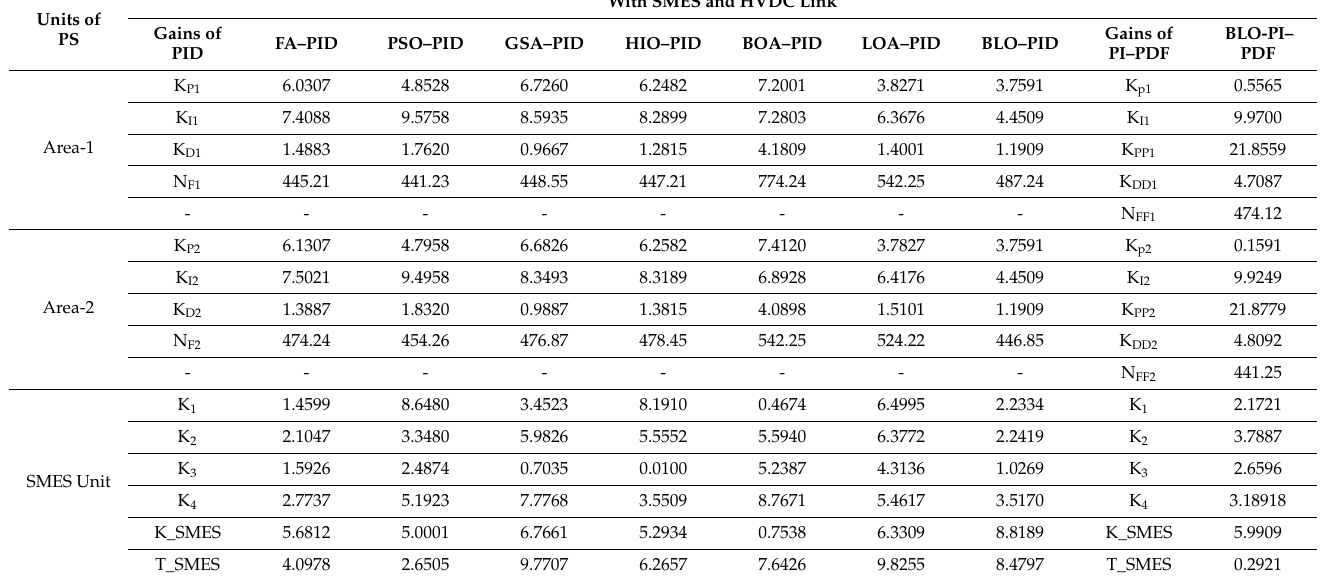
Table 4. Optimal value of the parameters for scenario-II.